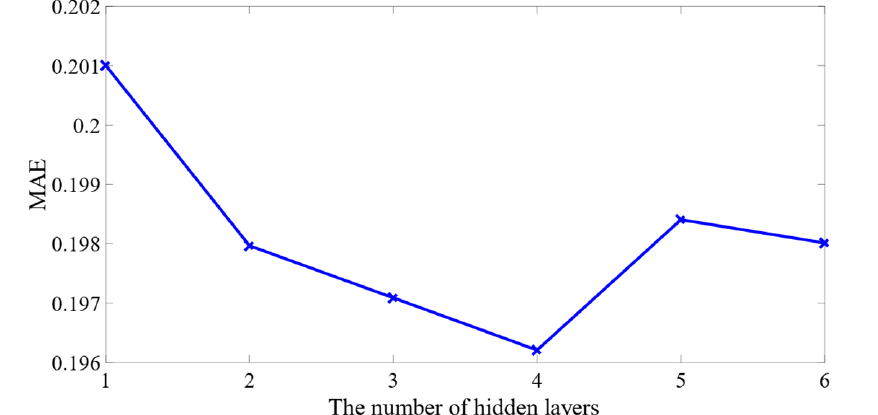
Figure 9. Changes of training accuracy under different number of layers.